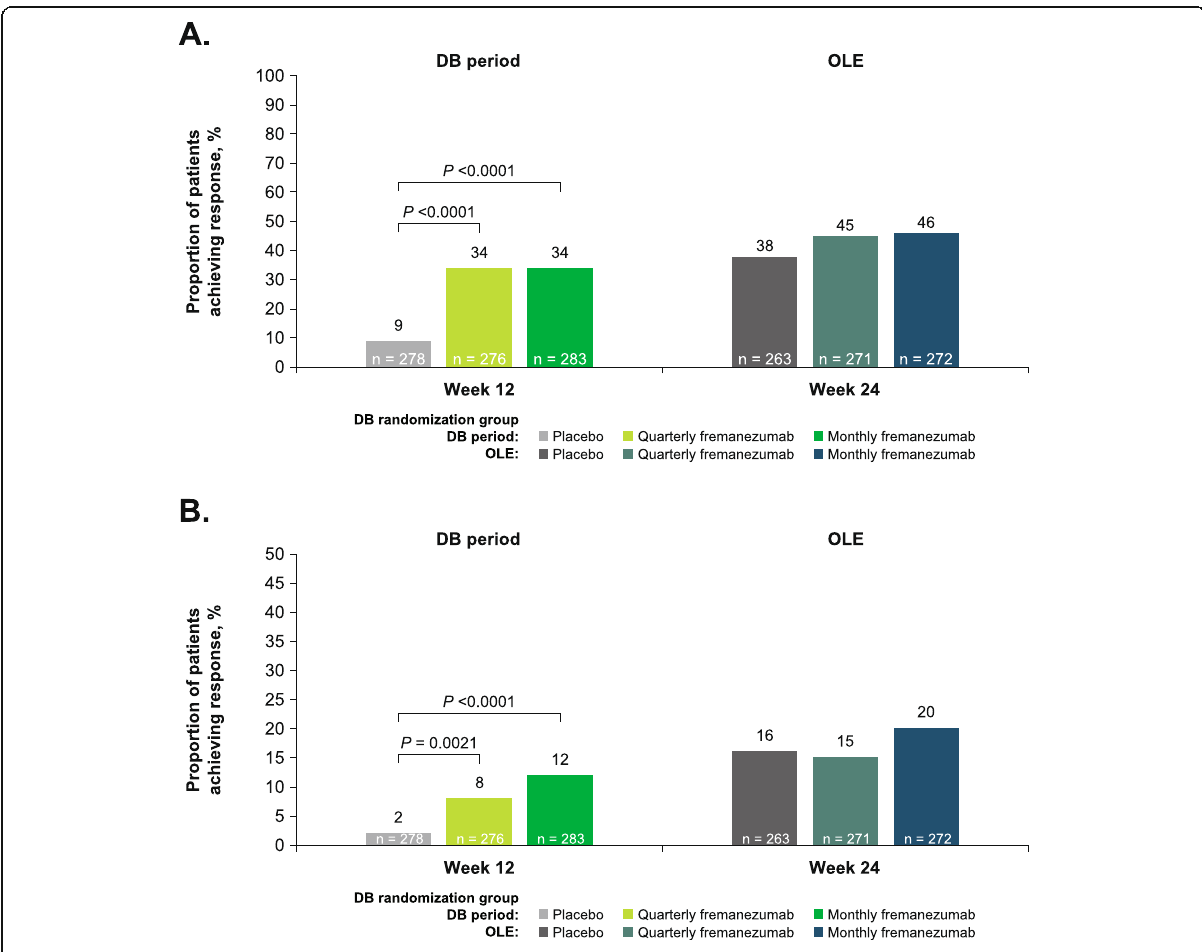
Fig. 4 Proportion of patients achieving a ≥ 50% reduction and b ≥ 75% reduction in the monthly average number of migraine days in the DB period and the OLE (mITT). a DB, double-blind; OLE, open-label extension; mITT, modified intent-to-treat. a All patients in the OLE